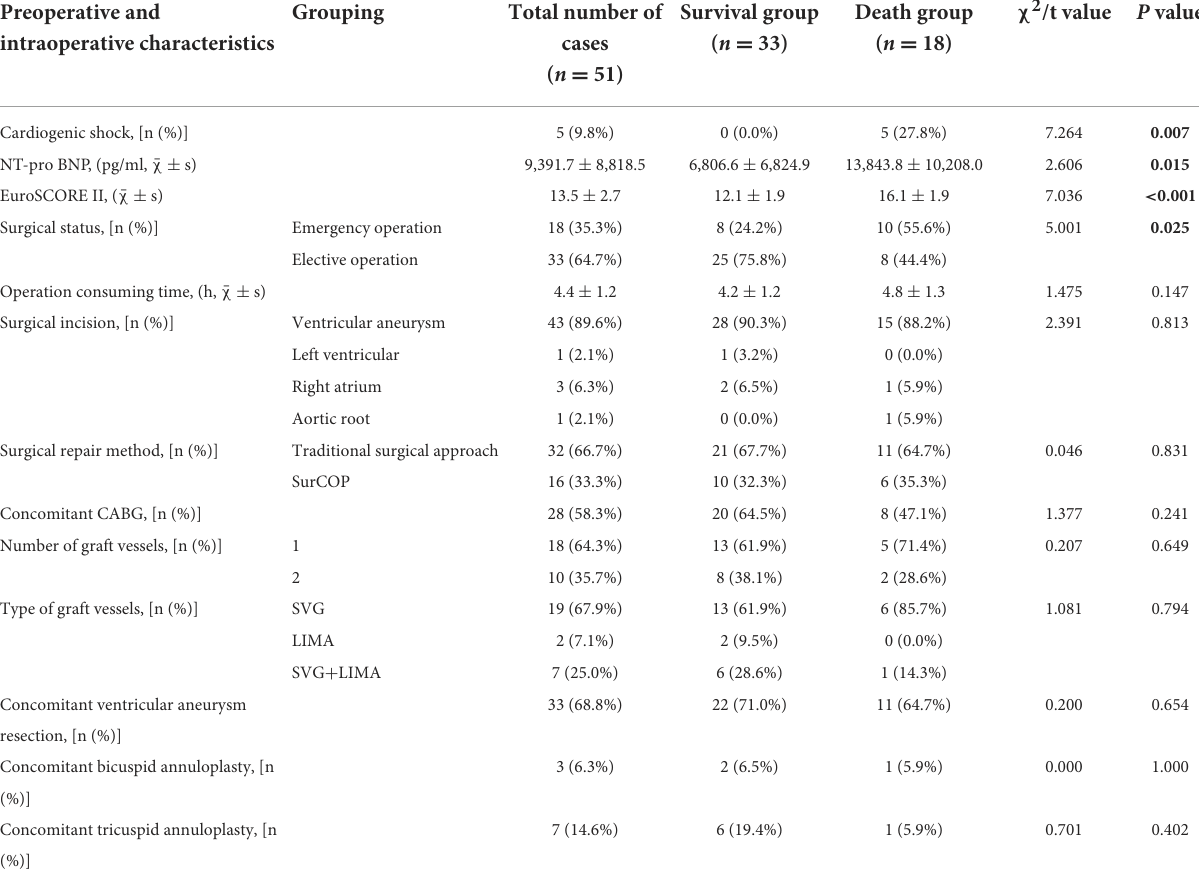
TABLE 4 Preoperative and intraoperative features of VSR patients in surgical repair group ( n = 51). Preoperative